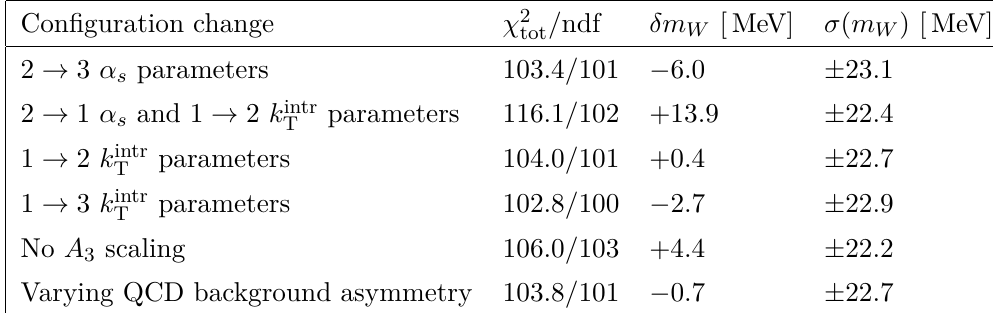
Table 9 . Fit results with variations in which physics parameters are varying